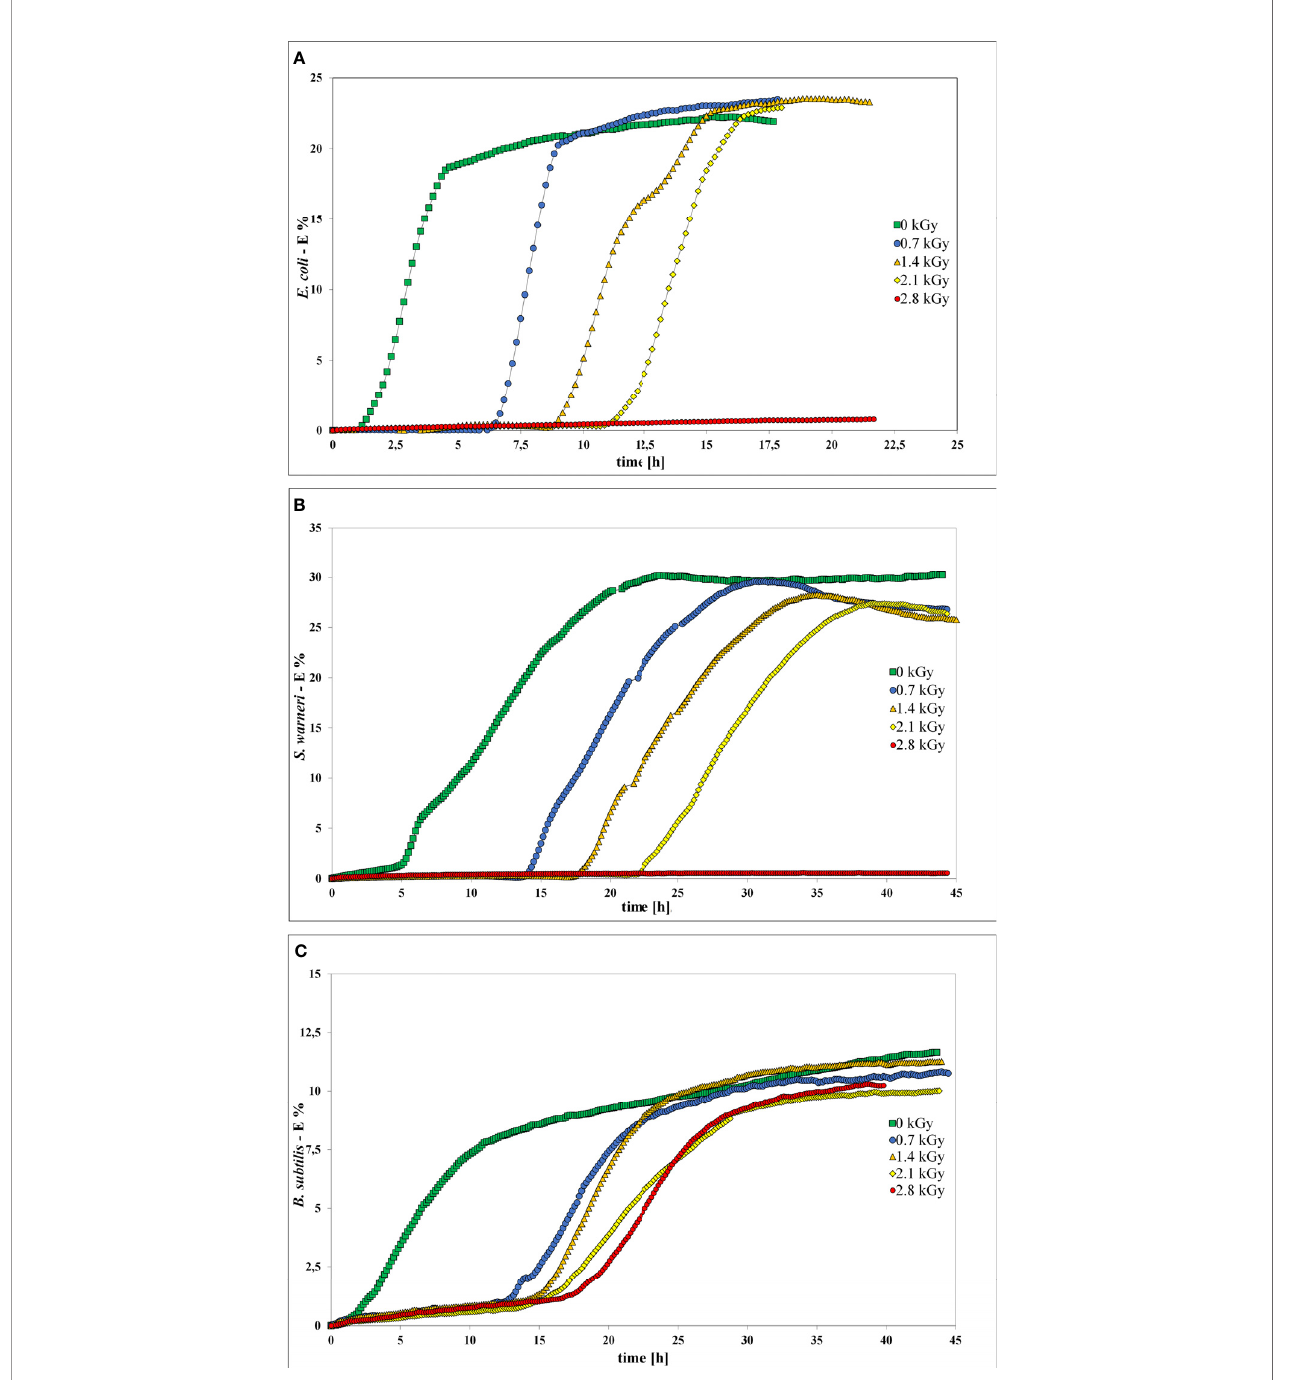
FIGURE 5 | Impedance spectra without (0 kGy, green rectangles) and after irradiation with at 0.7 kGy (blue circles), 1.4 kGy (orange triangles), 2.1 kGy (yellow rhombs), and 2.8 kGy (red rectangles). (A) E . coli . (B) S. warneri . (C) Vegetative cells of B. subtilis